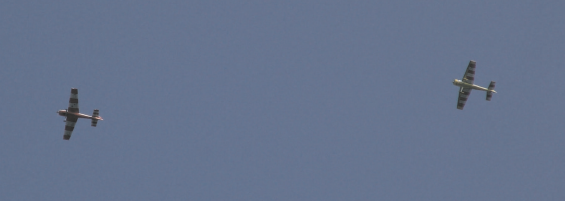
Figure 5: GTYak and GTEdge in